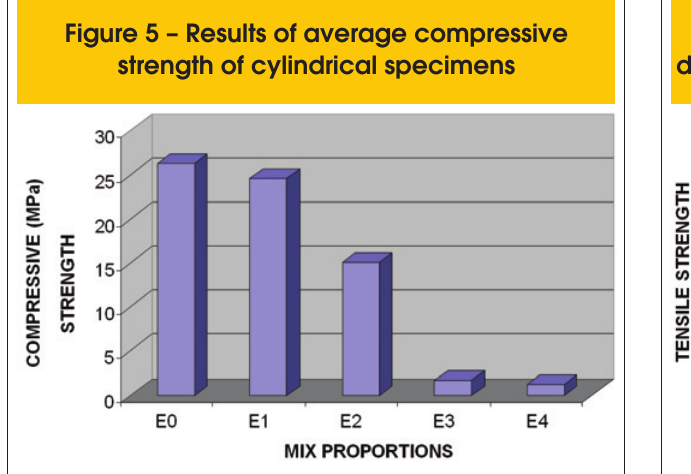
Figure 5 – Results of average compressive strength of cylindrical specimens